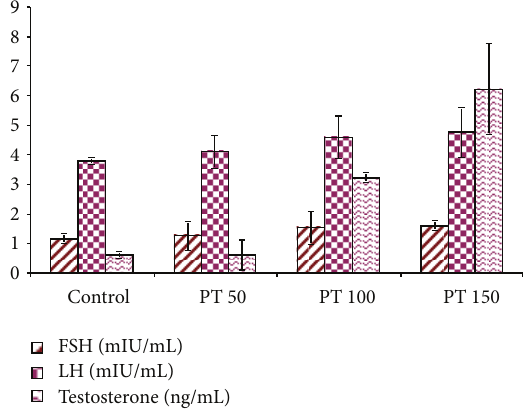
Figure 4: Effect of ethanolic extract of Pueraria tuberosa on hormones